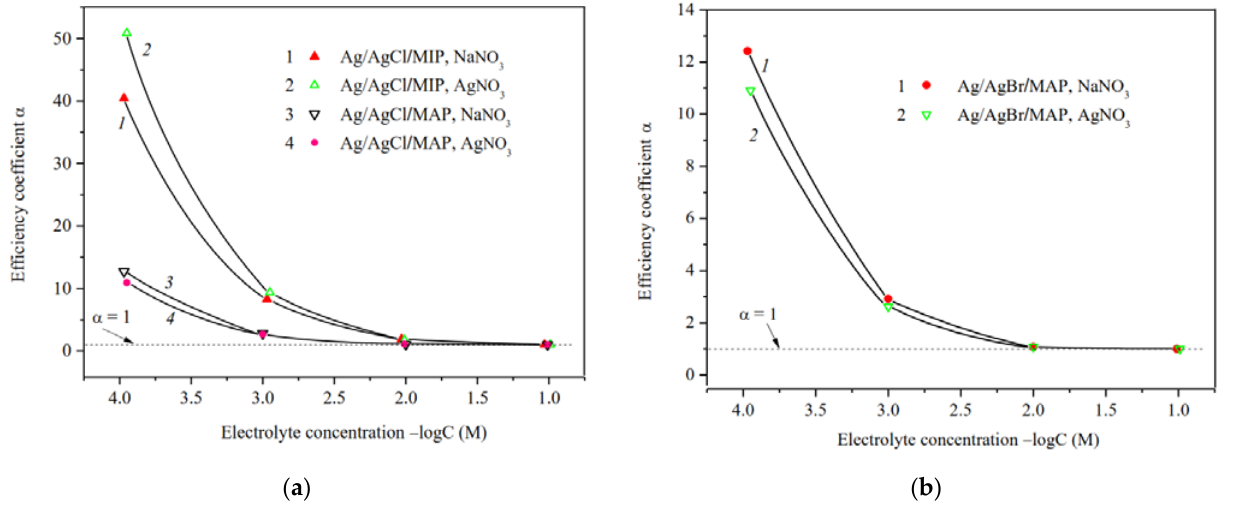
Figure 9. Efficiency coefficients of Ag/AgCl-doped MIP and MAP membranes ( a ) and Ag/AgBr/MAP ( b ) membranes vs. NaNO 3 and AgNO 3 solution concentration.